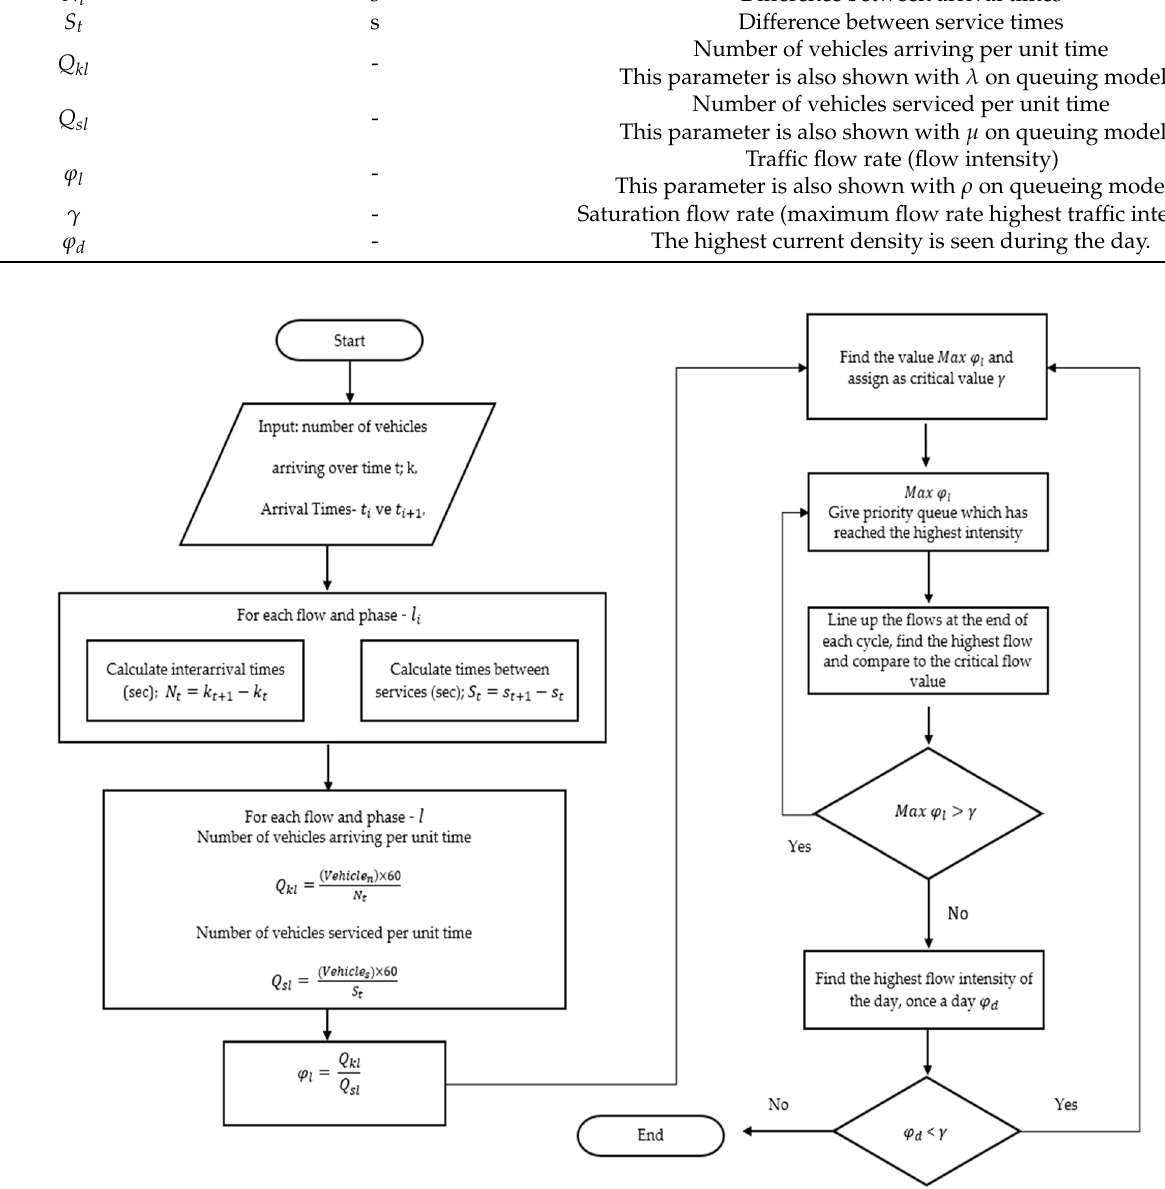
Figure 7. Flow diagram of dynamic phase sequences model for a signalized intersection.